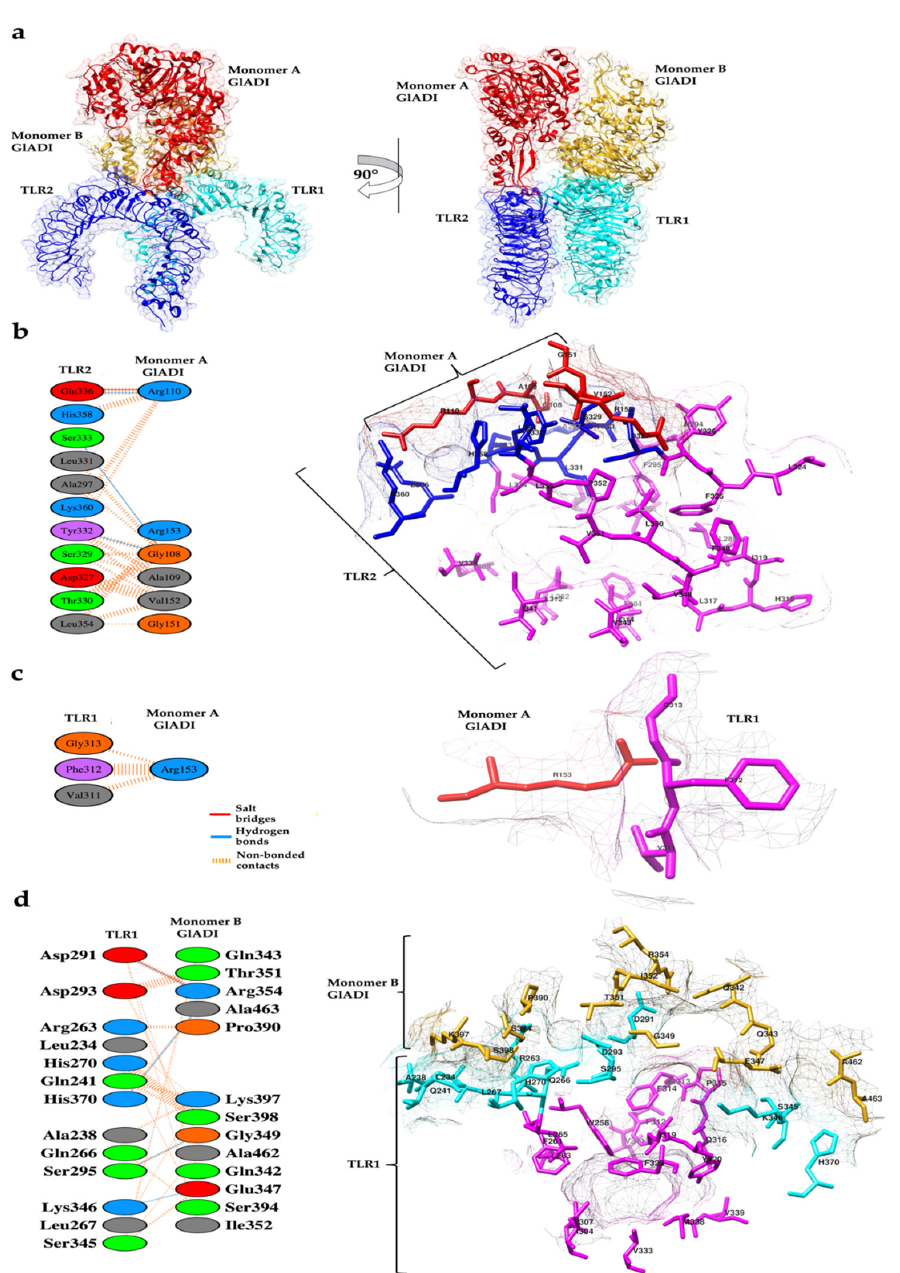
Figure 6. Predicted interactions between AlphaFold-predicted structure of GlADI and human TLR2-TLR1 heterodimer. ( a ) Two views of the predicted protein–protein interactions of GlADI with the ectodomains of human TLR2-TLR1. ( b ) Amino acid residues interacting between GlADI monomer A (red-colored, right side) and TLR2 (blue-colored, right side). ( c ) Amino acid residues interacting between GlADI monomer A (red-colored, right side) and TLR1 (magenta-colored, right side). ( d ) Amino acid residues interacting between GlADI monomer B (gold-colored, right side) and TLR1 (cyan-colored, right side). Amino acid residues magenta-colored (right side) are part of the ligand binding site of the TLR2-TLR1 heterodimer. Interacting amino acid residues are shown (left side). Structures displayed with UCSF Chimera. Docking was performed with HDOCK. Interactions analyses were made with PDBSum.